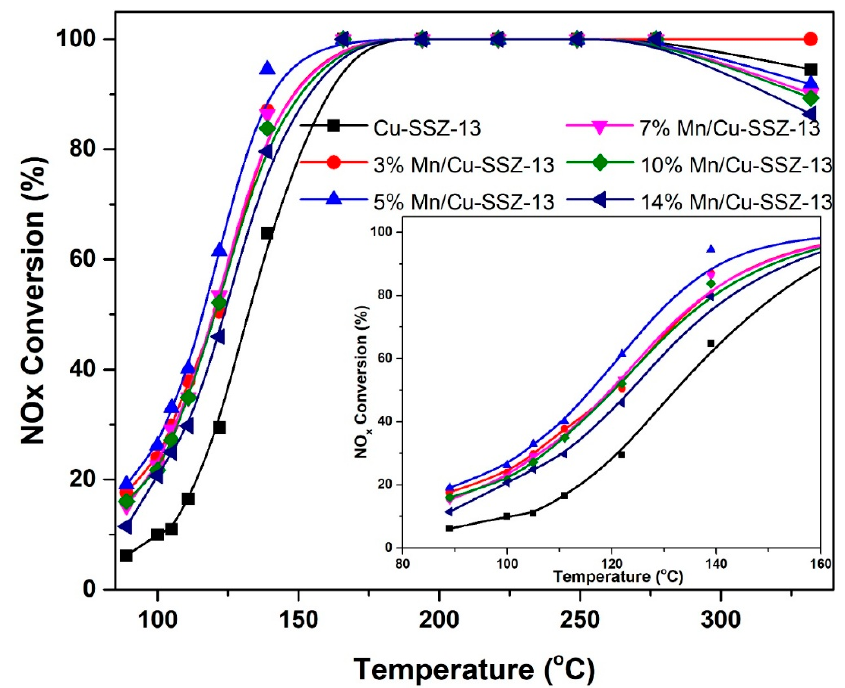
Figure 1. NH 3 -SCR performance of the prepared catalysts. Test conditions: [NO] = [NH 3 ] = 500 ppm, [O 2 ] = 5%, N 2 balance, GHSV = 100,000 h − 1 .